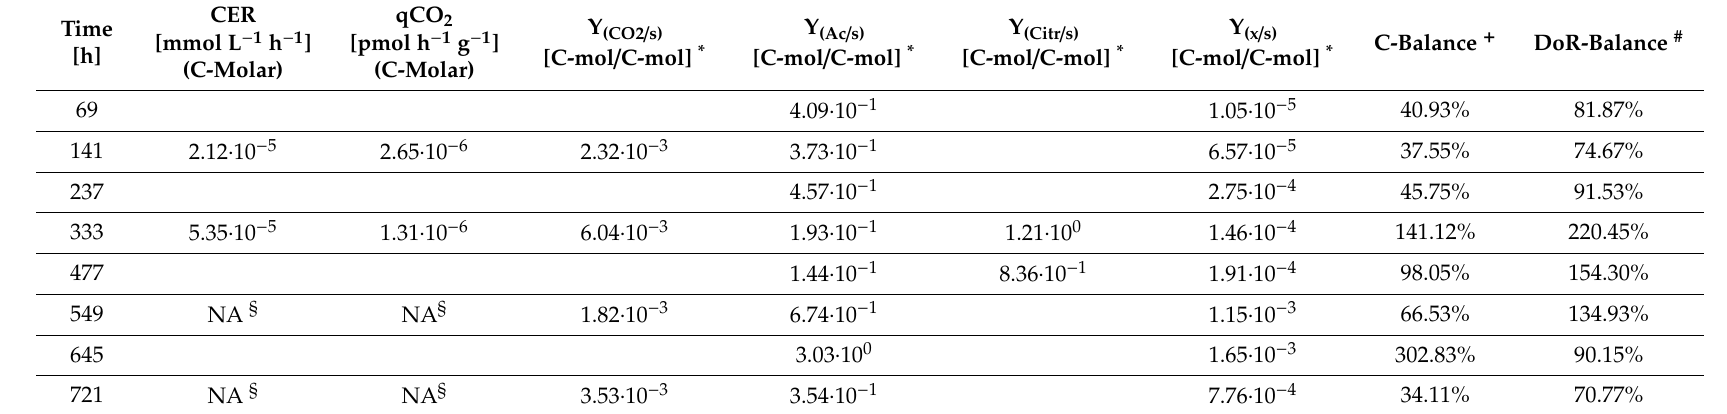
Table 3. Productivities and yields of D. amylolyticus grown on formic acid during time-point experiments.